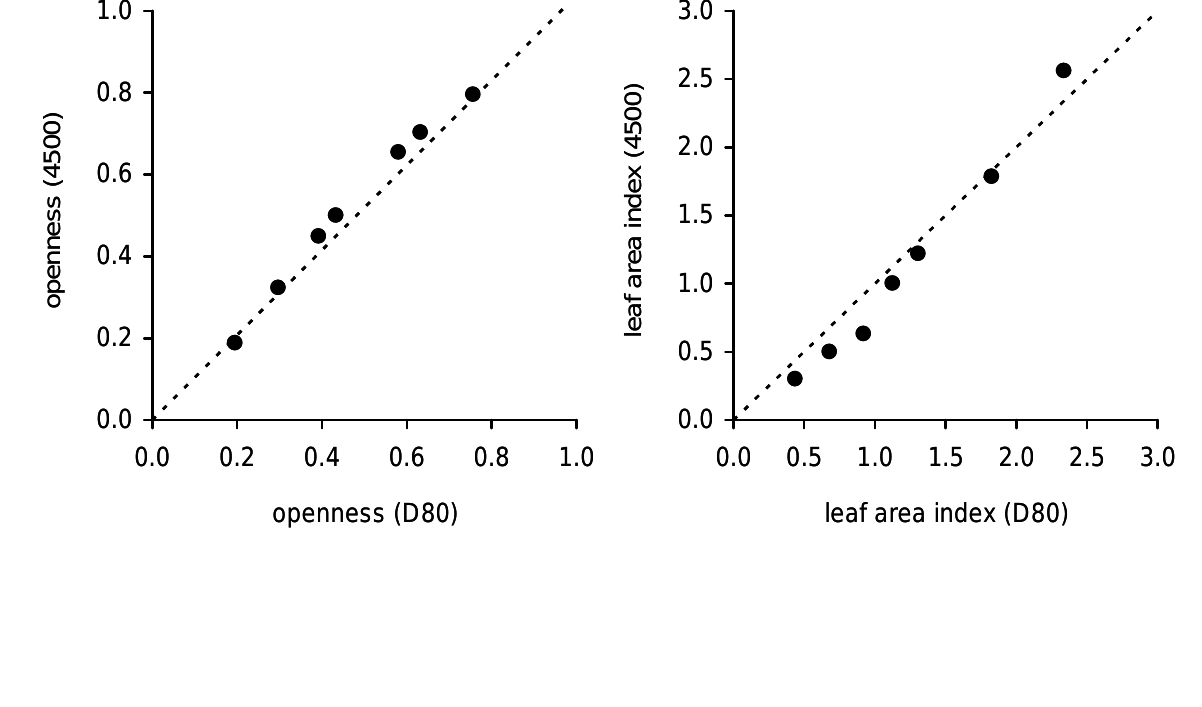
Figure 4. Comparison of openness, and leaf area index calculated after Lang and Xiang [40], obtained from the Nikon D80 DSLR camera and from the Coolpix 4500 camera using full-frame fisheye photography. Each data point is the mean of 5 images from the 4500 or 10 (medium and small combined) images from the D80. Standard errors (not shown) were between 0.01 and 0.04 for openness and 0.06 and 0.18 for leaf area index. The dashed line is the 1:1